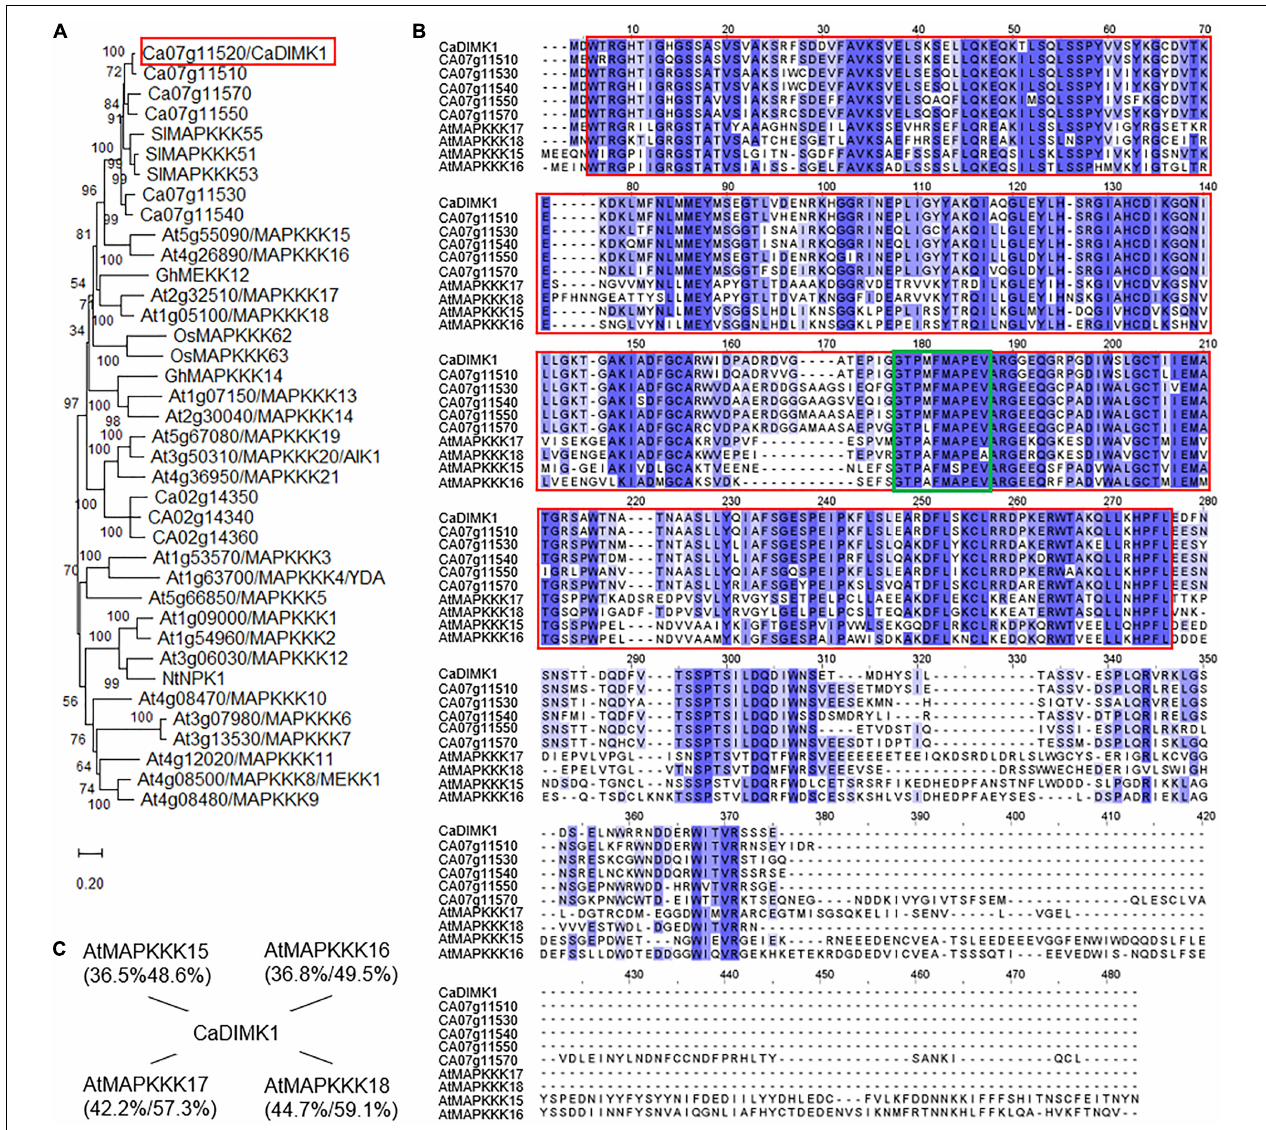
FIGURE 2 | Amino acid sequence analysis of CaDIMK1 . (A) Phylogenetic tree of pepper MAP3 kinases. The phylogenetic analysis was conducted via MEGA software (version 10.1) using the deduced amino acid sequences of MAP3 kinases from Arabidopsis , pepper, rice, cotton, tobacco, and tomato plants. The phylogenetic tree was built according to the neighbor-joining method, and bootstrap values were calculated from 1,000 bootstrap replications and are at each branch point. Scale bar indicates the evolutionary distance computed using the Poisson correction method. (B) Multiple alignment analysis of CaDIMK1 with its homologous Arabidopsis MAP3 kinases. Identical and similar amino acid residues are shaded according to the percentage identity in ClustalW2. Gaps introduced to maximize the alignment of homologous regions are marked by dashes. A red box indicates a serine/threonine protein kinase domain and a green box for a conserved kinase domain G(T/S)Px(W/Y/F)MAPEV in the MEKK-like group of the MAPKKK family. (C) Sequence homology of CaDIMK1 with its homologous Arabidopsis MAP3 kinases. In parenthesis, protein identity and similarity were calculated using EMBOSS needle